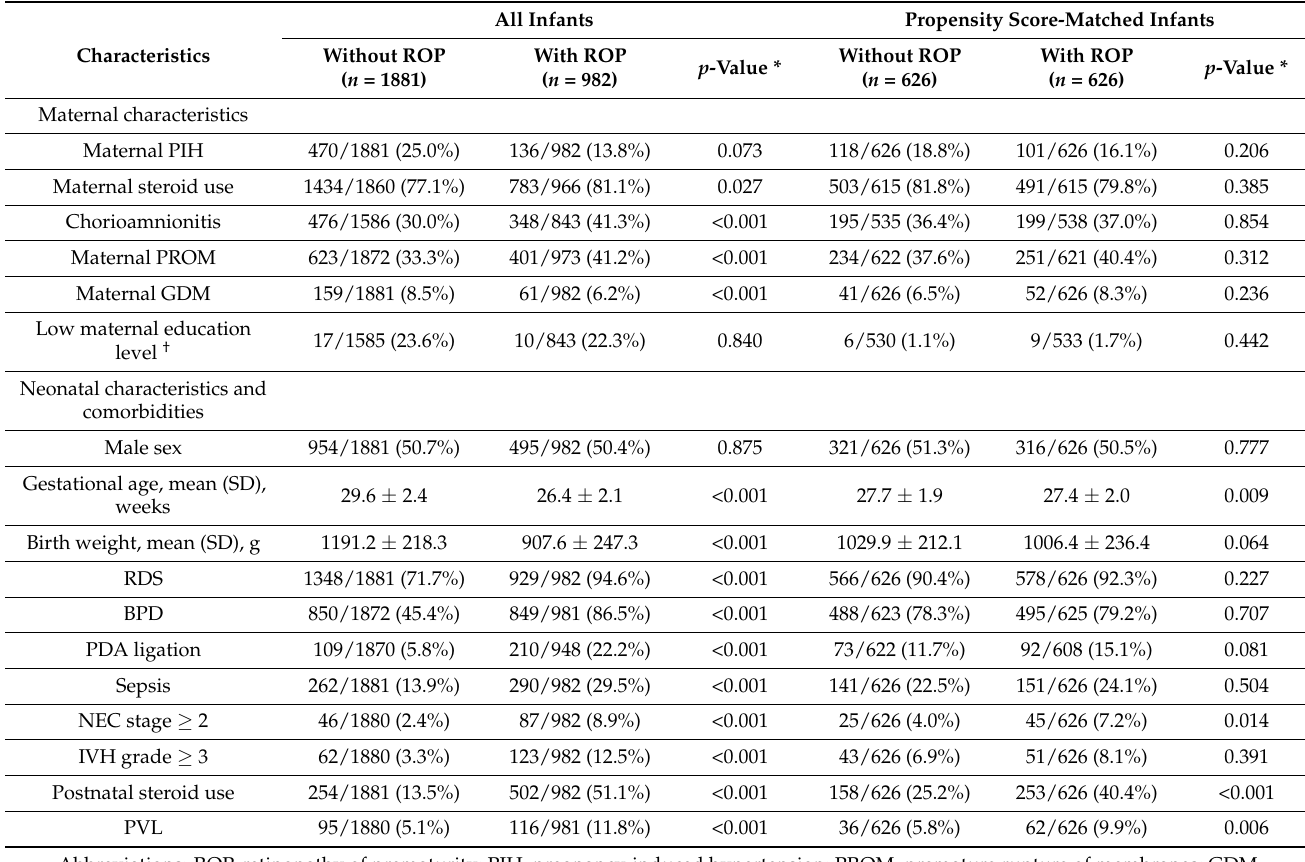
Table 1. Demographic and clinical characteristics of premature infants with and without retinopathy of prematurity among those who received ophthalmic and hearing assessment at follow-up